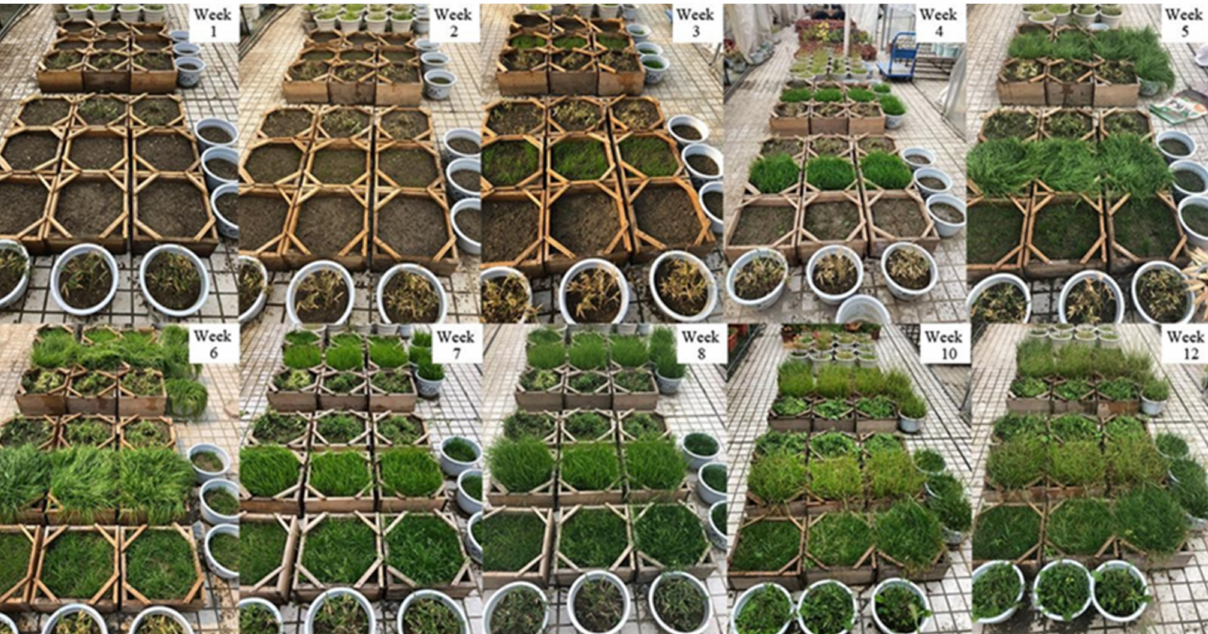
Figure 6. Photographs of plant growth from week 1 to week